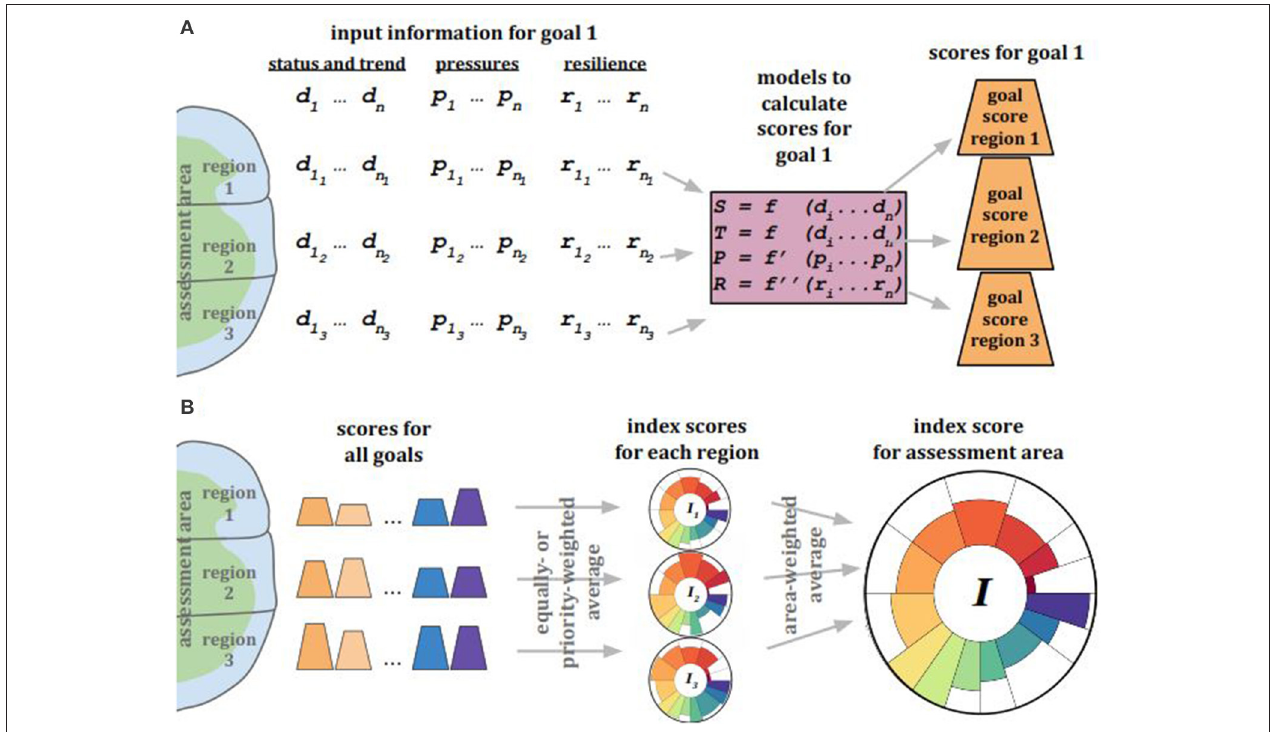
FIGURE 5 | Ocean Health Index scores are calculated for each goal and for each spatially defined and non-overlapping region within the assessment area. (A) To calculate scores for a single goal, the best locally available information for each region is used for status and trend (d), pressures (p), and resilience (r). This information is used in mathematical models to calculate the status (S) and trend (T) of that goal, as well as the pressures (P) and resilience (R) relevant to that goal. S, T, P, and R are to calculate a score for each goal for each region. This process is done for all goals and sub-goals in the assessment framework. (B) After all scores are calculated for all goals for every region, those goal scores are combined with equal weighting (by default; unequal weighting based on context-specific priorities is possible) for each region to produce an Index score for each region, and finally for the entire assessment